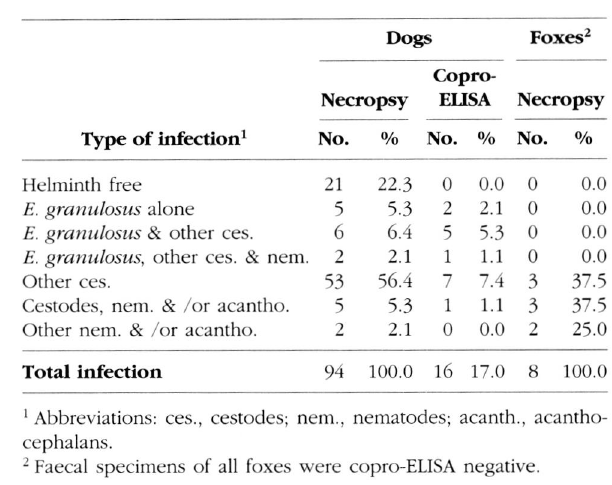
cephalans. - Faecal specimens of all foxes were copro-ELISA negative. Table III. - Intestinal helminth fauna and infection rates in dogs and foxes from northern Jordan. Necropsy data were used to assess the diagnosis of E. granulosus coproantigens by capture